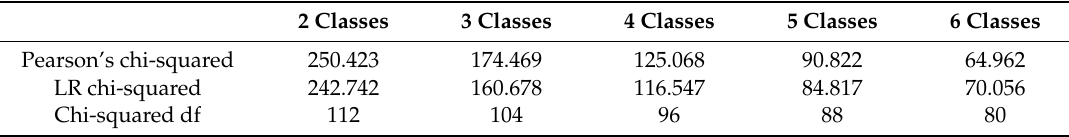
Table 3. Latent class model fit